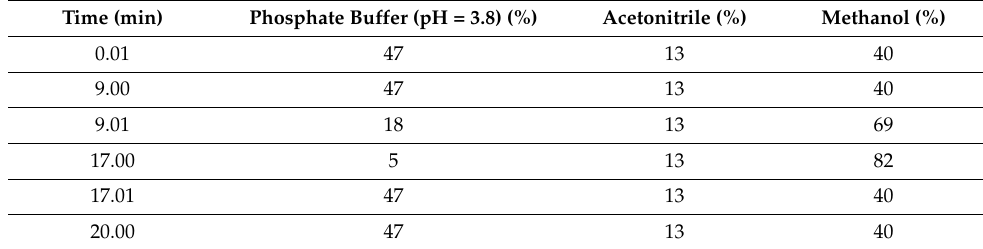
Table 1. HPLC gradient elution programming for UGT2B17 enzyme